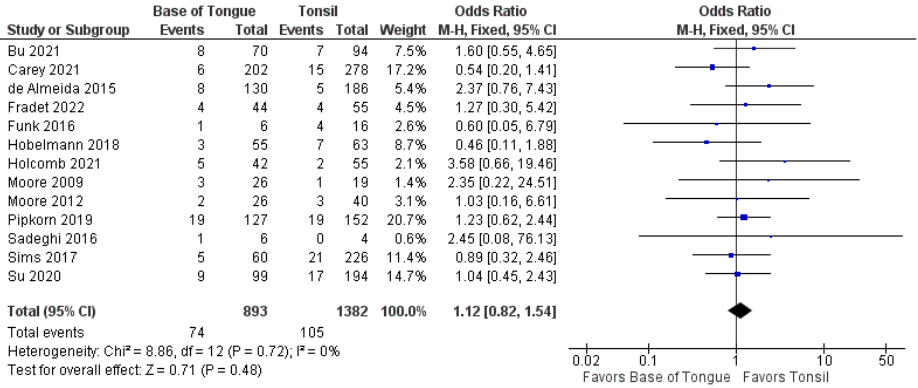
Figure 4. Comparison of total recurrence between tonsillar OPSCC and base of tongue OPSCC.